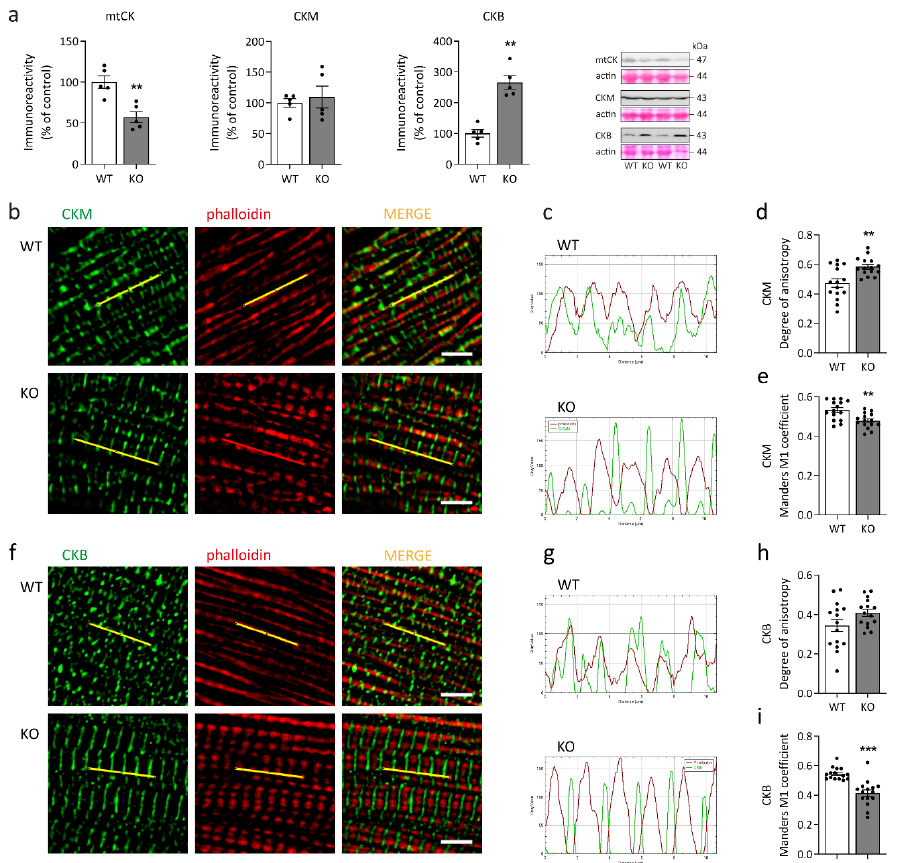
Figure 5. Creatine kinase protein levels and localization in desmin knock-out cardiac tissue. ( a ) Immunoblot analysis addressing the protein levels of mitochondrial creatine kinase (mtCK) as well as the cytosolic CKM and CKB in left ventricular cardiac tissue homogenates from desmin knock-out mice (KO) and their wild-type siblings (WT). Note the significantly lower protein level of mtCK and the higher level of CKB in desmin knock-out mice. Representative immunoblots and Ponceau S-stained membranes are shown. The apparent molecular weight of both CKM and CKB is 43 kDa and of mtCK 47 kDa. For each CK isoform, homogenates from five animals per genotype were analyzed in duplicate; Mann-Whitney test, ** p < 0.01. ( b , f ) The subcellular localization of CKM and CKB (green) in relation to actin filaments (red) was visualized in longitudinally oriented cardiomyocytes. Scale bar, 5 µ m. ( c , g ) Fluorescence intensity line profiles of both creatine kinases (lines indicated in yellow in panels ( b ) and ( f )) demonstrated a phase-shift along the longitudinal axis of the myofibrils in the desmin knock-out cardiac tissue. ( d , h ) The degree of anisotropy of CKM ( d ) and CKB ( h ) fluorescence signals, which addresses the regularity of the striated signal patterns, showed only a significant increase in the case of CKM (five images of different regions of cardiac muscle tissue specimens from each of the three animals of each genotype were analyzed; Mann–Whitney test, ** p < 0.01). ( e , i ) Quantitative analysis based on the Manders M1 coefficient determined a significantly decreased colocalization of both CKM (e) and CKB (i) with actin filaments in the desmin knock-out genotype (five images of different regions of cardiac muscle specimens from each of the three animals of each genotype were analyzed; Mann-Whitney test, ** p < 0.01, *** p < 0.001). Values in ( a , d , e , h , i ) are given as mean ±